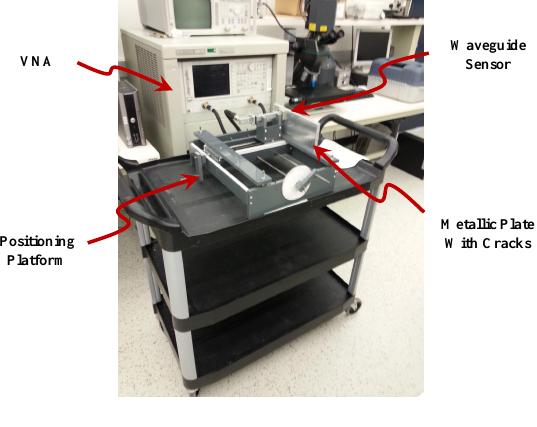
Figure 3. Testing configuration .